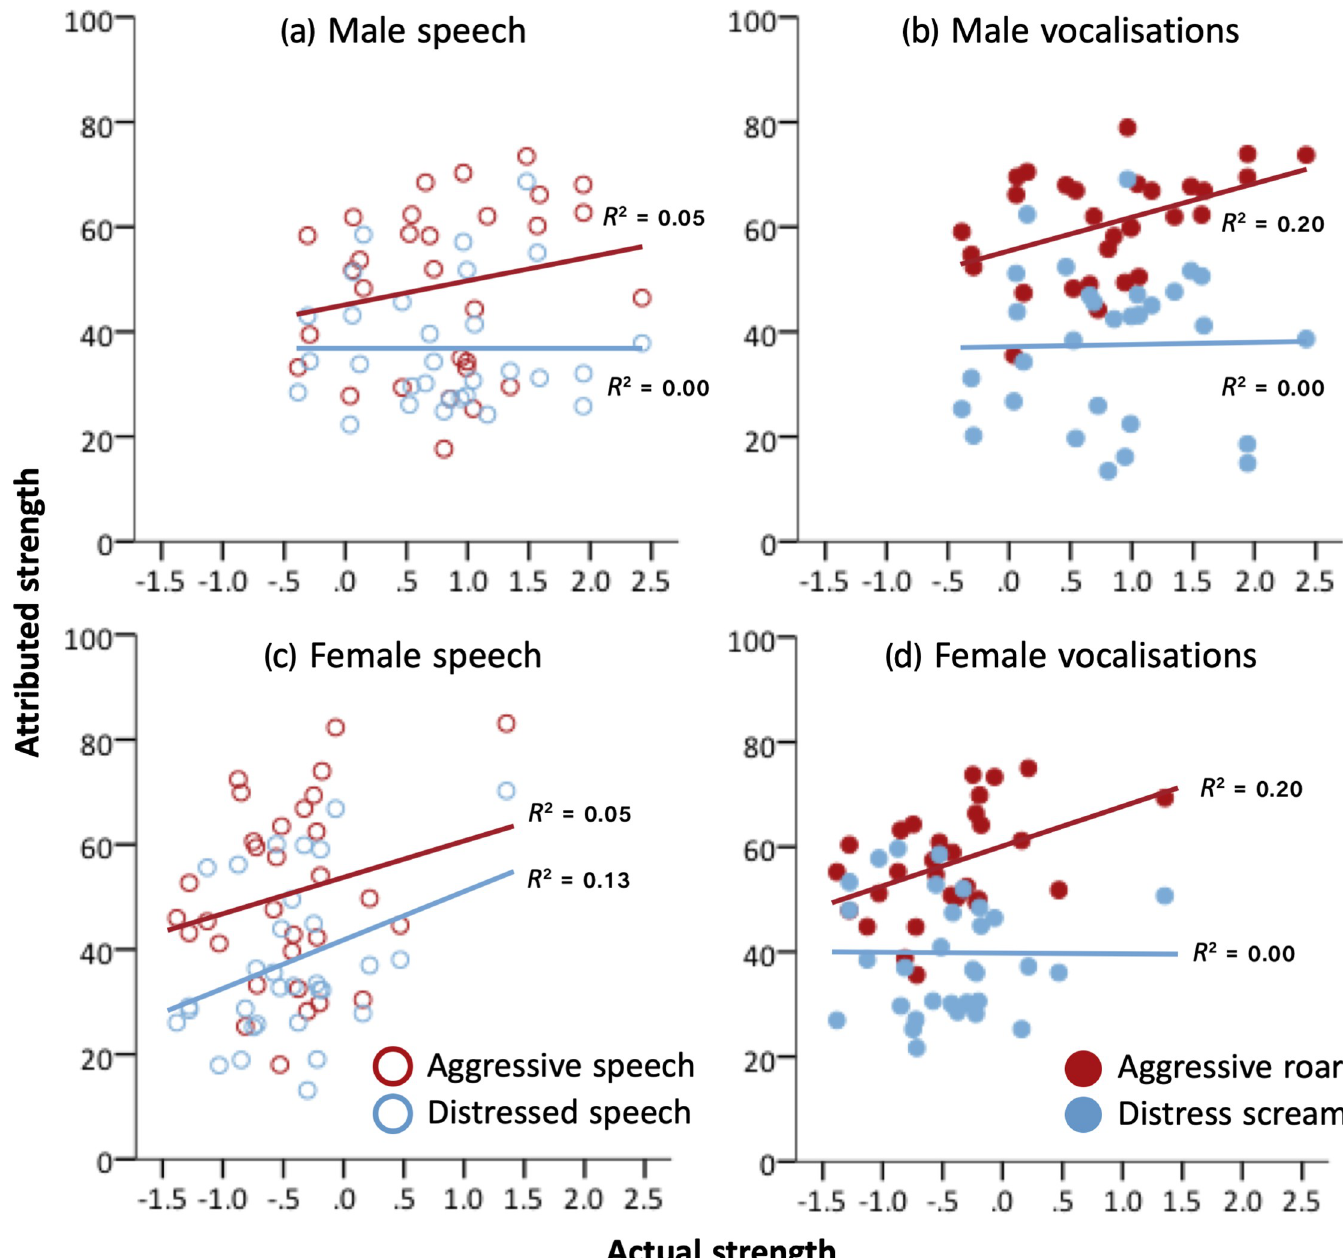
Fig 3. Attributed strength as a function of actual strength, when listeners rated (a) male speech stimuli, (b) male vocalizations, (c) female speech stimuli, and (d) female vocalizations. Each data point represents the mean strength rating averaged across listeners attributed to each vocalization. Blue circles represent distress stimuli, red circles represent aggressive stimuli. Open circles represent speech stimuli, closed circles represent vocalizations. R 2 values for each regression line are reported in the graphs. Removing the strongest female vocalizer from our analyzes did not affect the significance of our results.